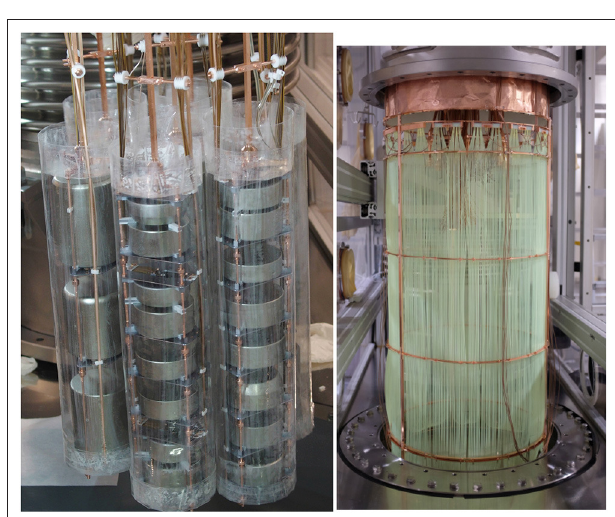
FIGURE 7 | (Left) A photograph of the strings of detectors for GERDA. (Right) A photograph of the scintillation light collection system that surrounds the Ge detectors. Photos courtesy of the GERDA